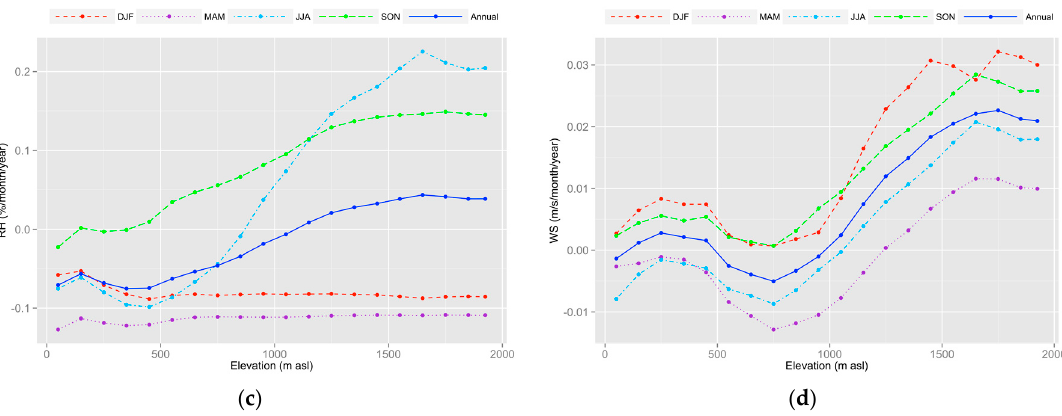
Figure 11. Elevational variation in the annual change in monthly meteorological data. ( a ) T max ; ( b ) T min ; ( c ) RH; ( d ) WS. The solid blue line represents the annual average; the seasonal averages for DJF, MAM, JJA, and SON are presented using dashed red, dotted purple, dashed-dotted light blue, and dashed green lines, respectively.